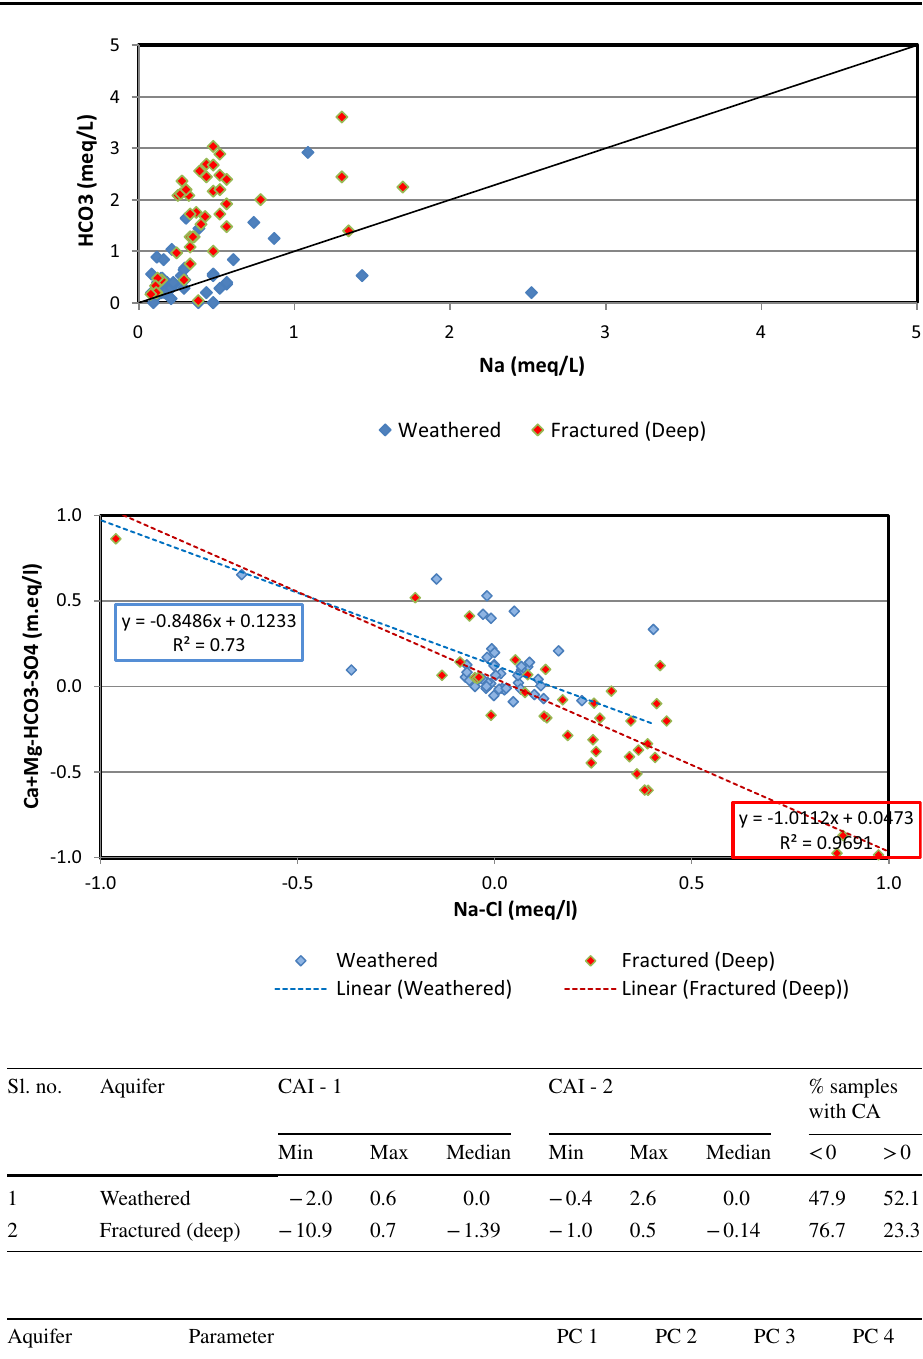
variance explained by factors in